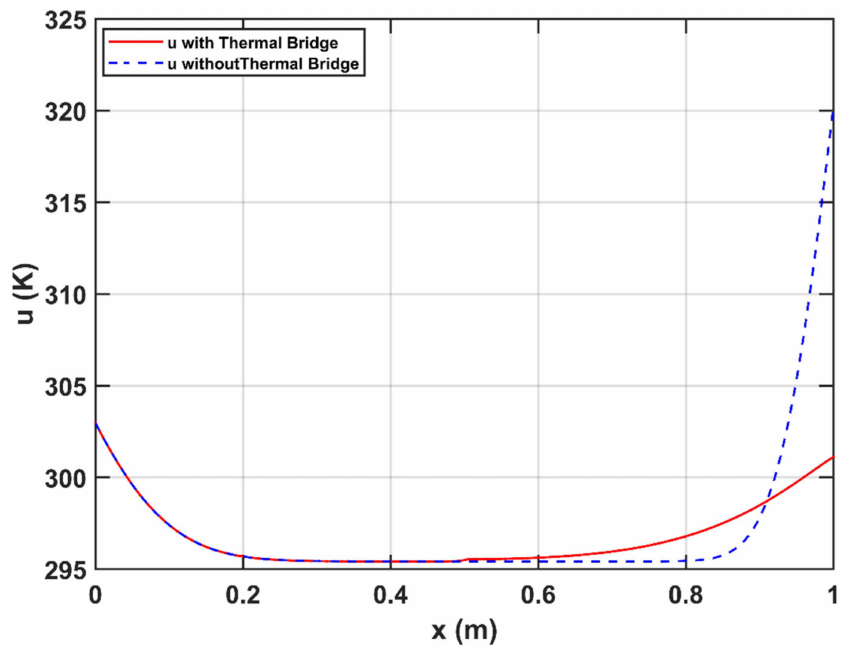
Figure 17. The temperature as a function of the space variable x at the middle row ( z ≈ 0.5 ) in the case of the multilayer insulated wall with and without thermal bridging using an equidistant